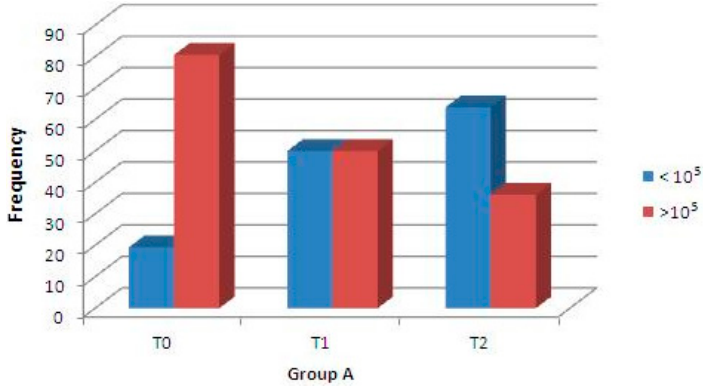
Molecules 2016 , 21 , 1008 4 of 10 Figure 3. In vivo release of quercetin (mean ± S.D.) from different gum formulations by a chew-out study performed by 32 participants (three samples for each participant, for two experiments) over a 30 min period. Saliva was collected at 5, 10, 20, and 30 min. 2.3. In Vivo Assessment of Antimicrobial Activity A second clinical trial was performed to analyze the antibacterial capability of these enriched chewing gums against S. mutans strains after 14 days of daily consumption. Concerning Group A samples, using regression binary logistic analysis, the microbiological assay of S. mutans concentration (CFU/mL) at baseline (T0) and after 7 days (T1), and between baseline (T0) and after 14 days (T2) showed